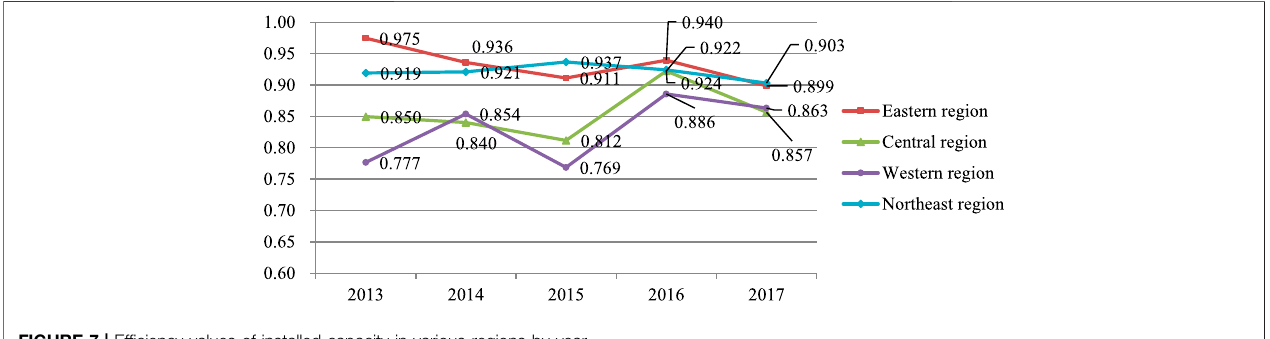
Frontiers in Energy Research |